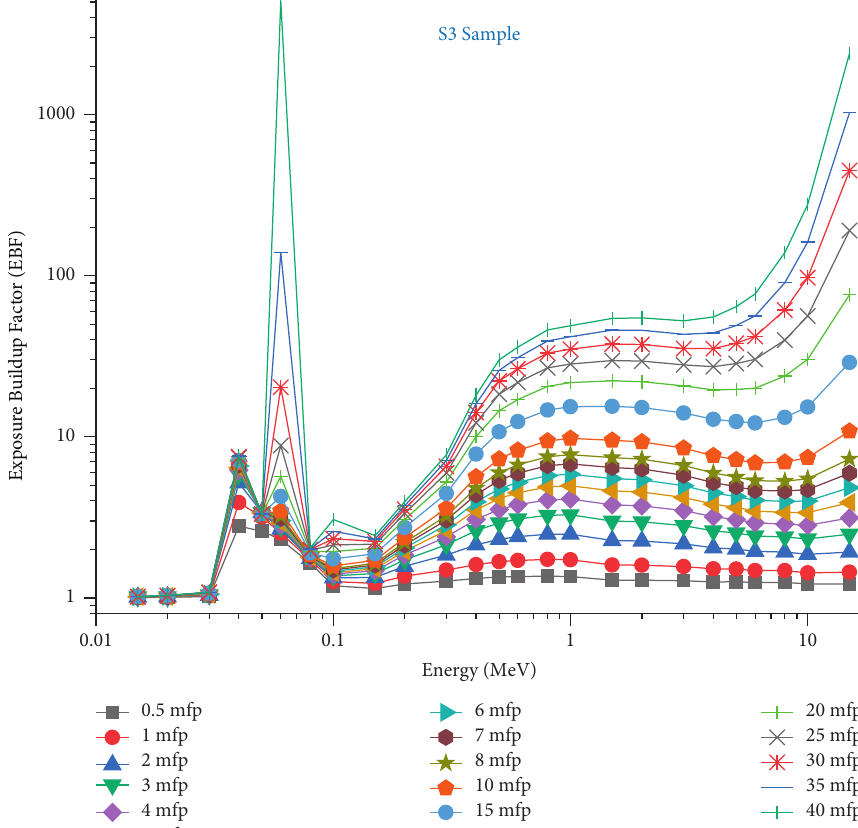
Figure 14: Demonstrates the relationship between the energy and EBF of the S3